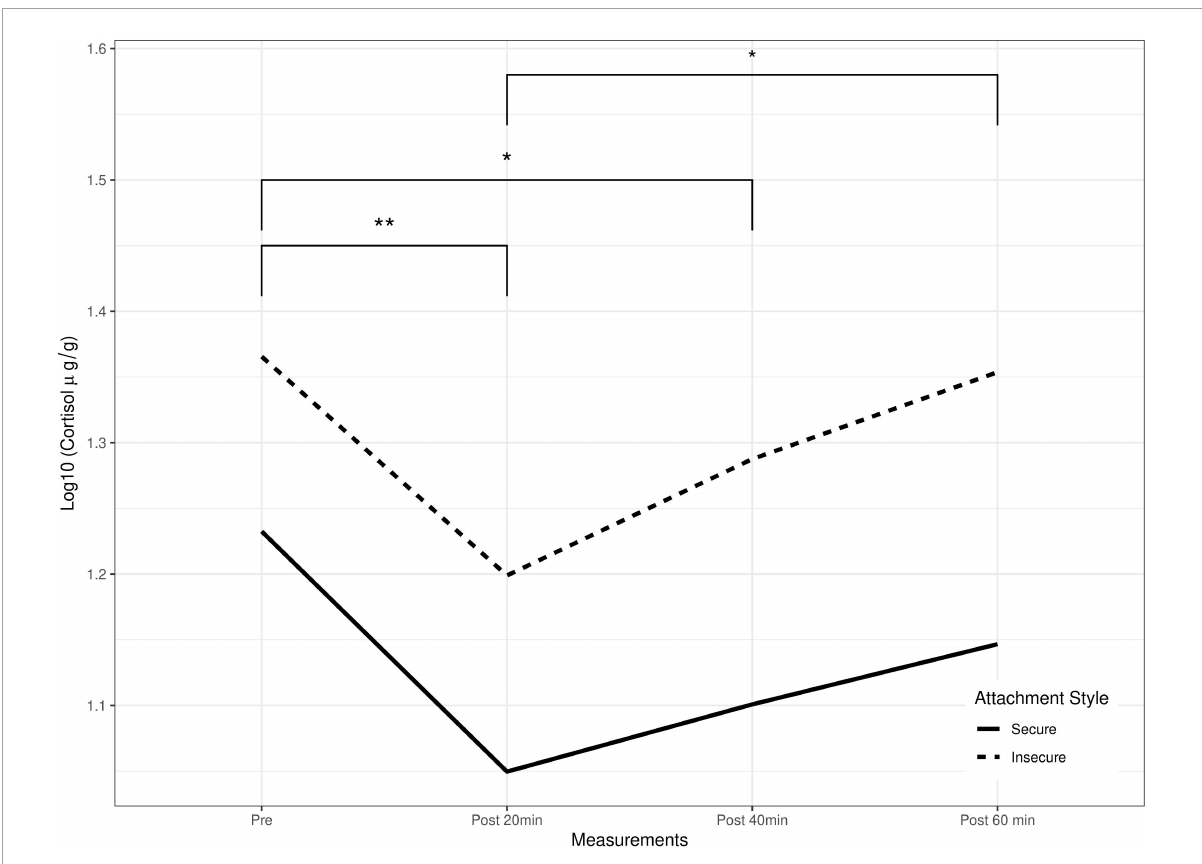
FIGURE1 Salivary cortisol levels as a function of time and attachment style. GEE’s predicted cortisol as a function of attachment styles and repeated measures, *p < 0.05 , **p <